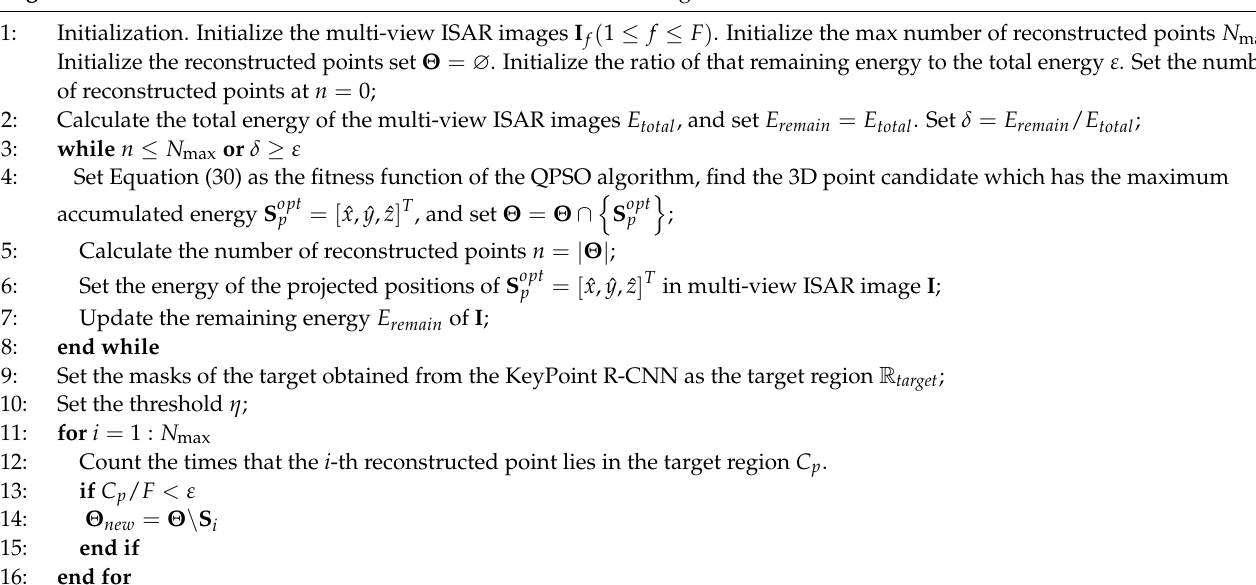
Algorithm 1: 3D Reconstruction Method from Multi-View ISAR